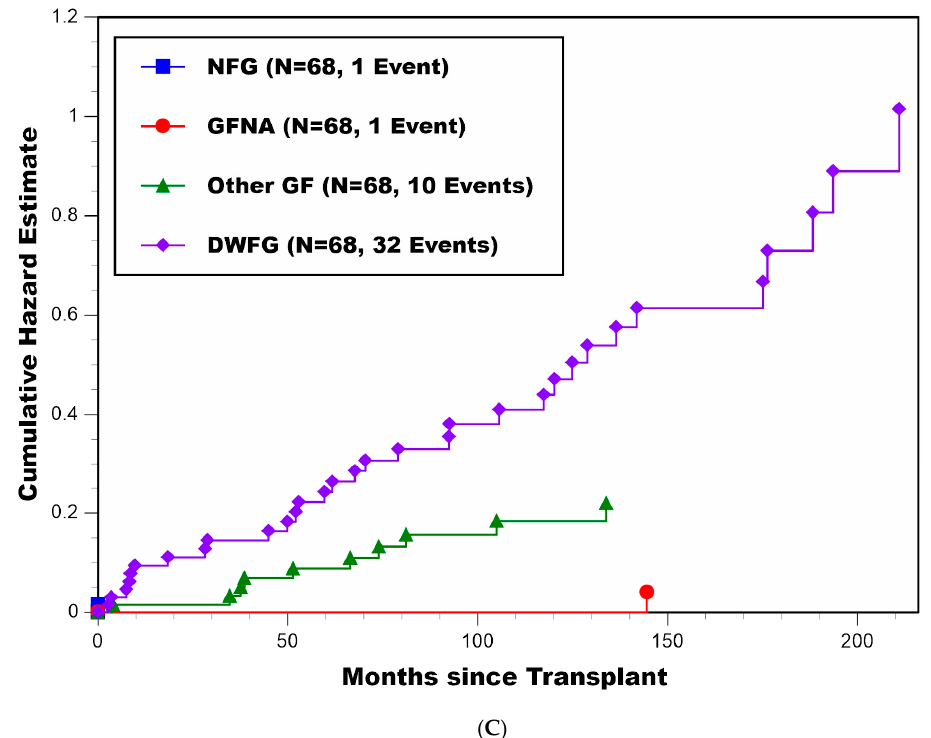
Figure 1. ( A ) Cumulative hazard plot of four distinct causes of graft loss (NFG, GFNA, Other GF, and DWFG) for all patients combined; ( B ) cumulative hazard plot of four distinct causes of graft loss (NFG, GFNA, Other GF, and DWFG) for patients <50 years of age at transplant; ( C ) cumulative hazard plot of four distinct causes of graft loss (NFG, GFNA, Other GF, and DWFG) for patients ≥ 50 years of age at